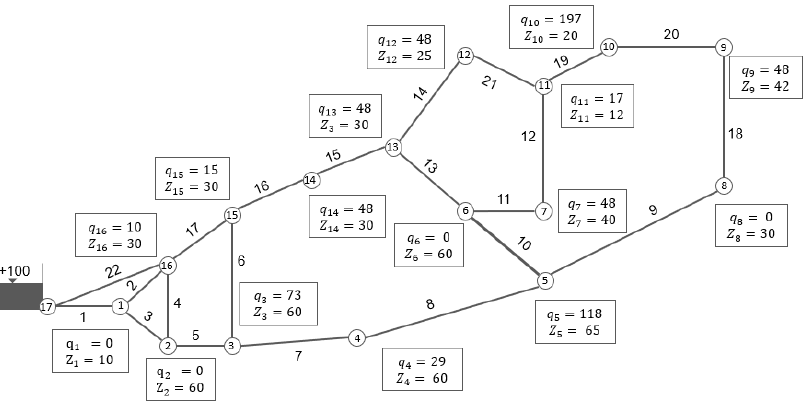
Figure 1. Network schematic of FOWM distribution system (Ormsbee and Kessler 1990).